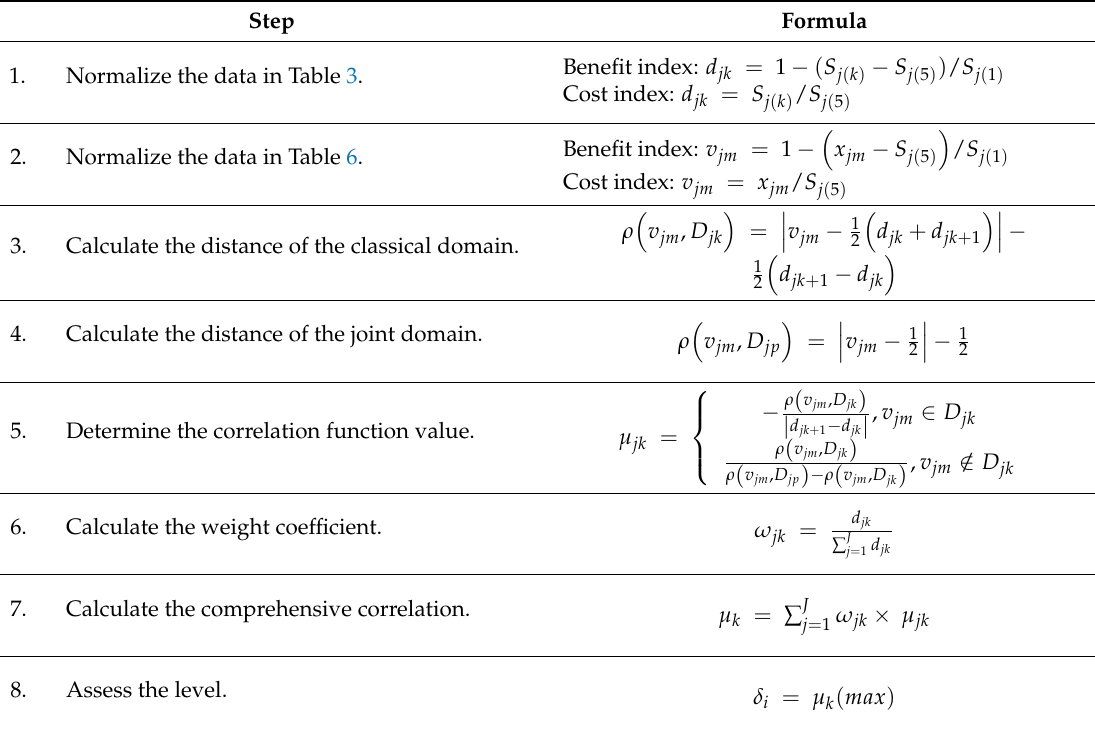
Table A5. The step and formula of MEM.